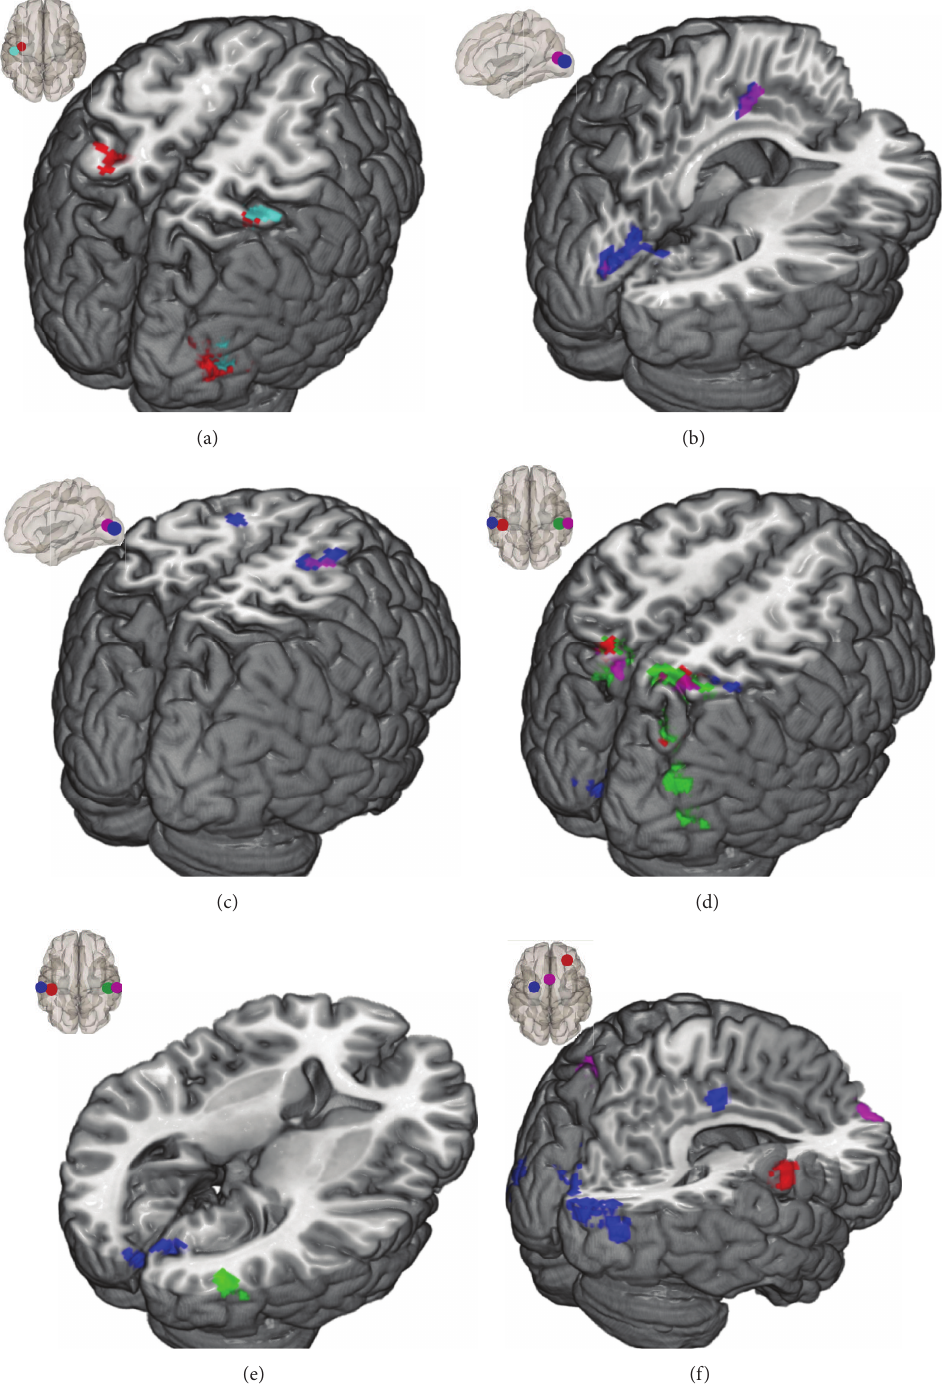
Figure 1: Greater connectivity increases in trainees compared to controls subjects; seed regions are represented in the small brain images; seeds determine the colour of the result region: (a) BA4 left: red and BA1 left: cyan; (b) and (c) visual cortex: BA17 right: violet and BA18 right: blue; (d) and (e) auditory cortex: BA41 right: green, BA41 left: red, BA42 right: violet, and BA42 left: blue; (f) dorsolateral prefrontal cortex: right: red, FEF left: blue, and midcingulate cortex: